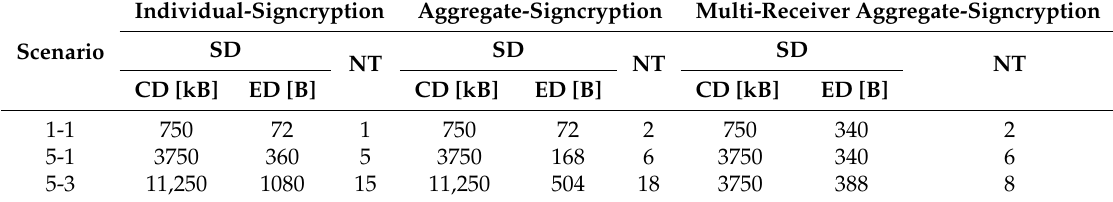
Table 7. Comparisons of communication efficiency in terms of transferred data and number of data transfers of different approaches for one smart camera/one monitoring device (1-1), five smart cameras/one monitoring device (5-1) and five smart cameras/three monitoring devices (5-3).